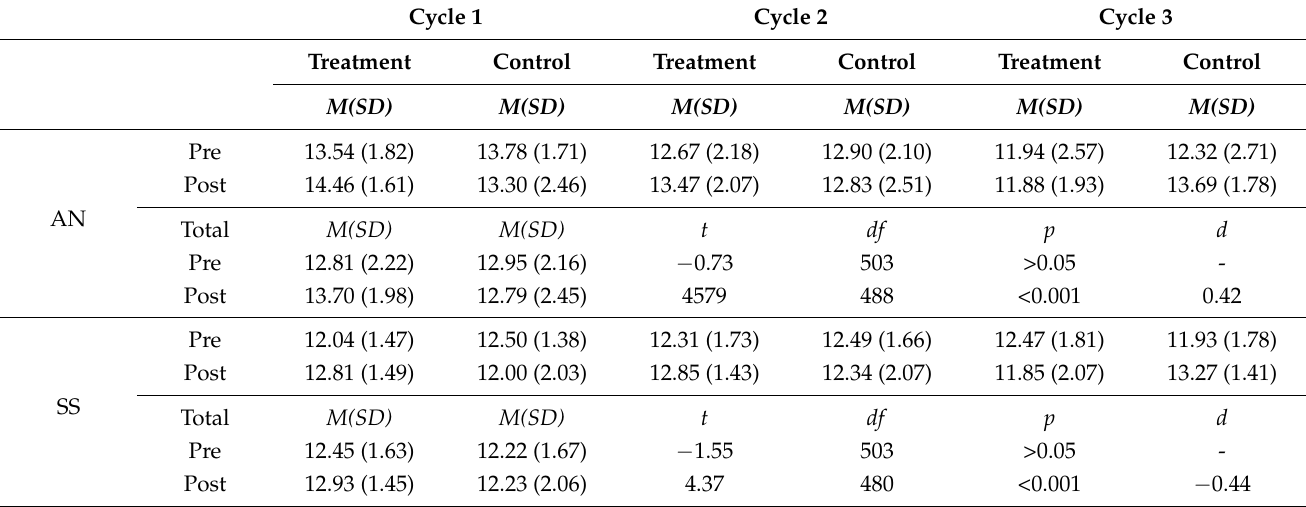
Table 2. Means ( M ) and standard deviations ( SD ) for the treatment and control group in the pretest and the post-test for the three primary school